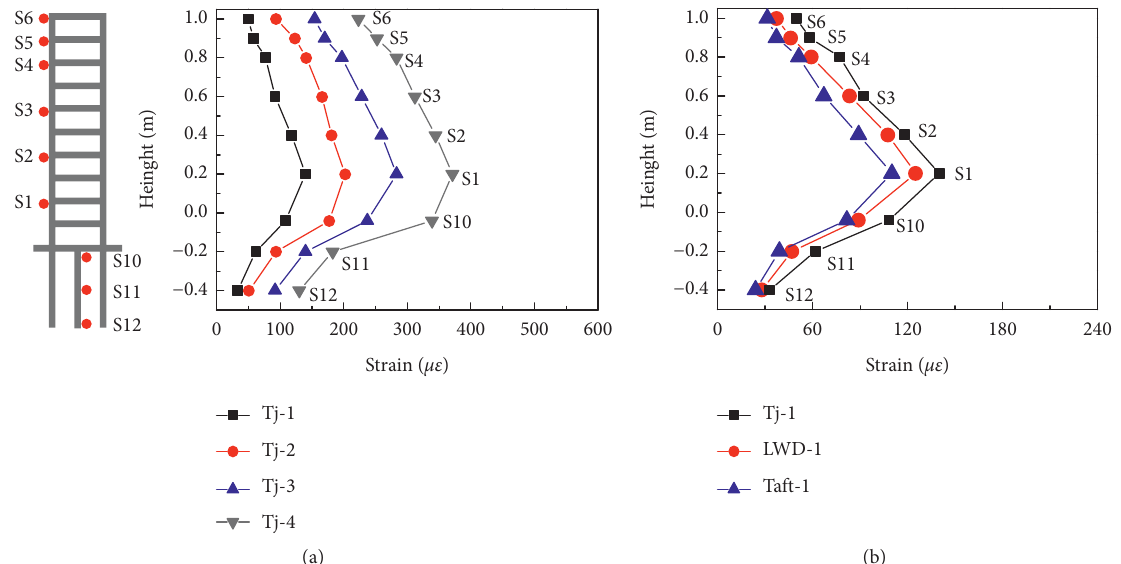
Figure 14: Strain envelope diagram of the surface structure-pile system. (a) System under Tianjin wave. (b) System under different seismic